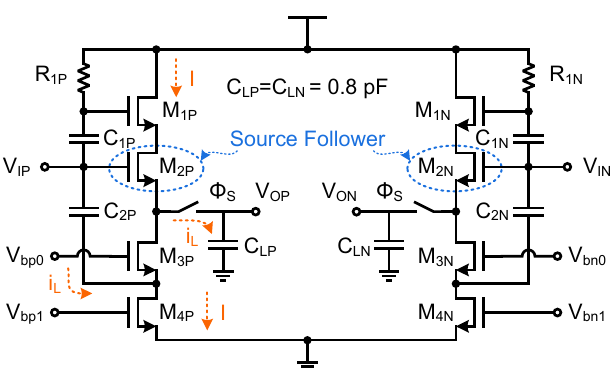
Figure 4. The differential input